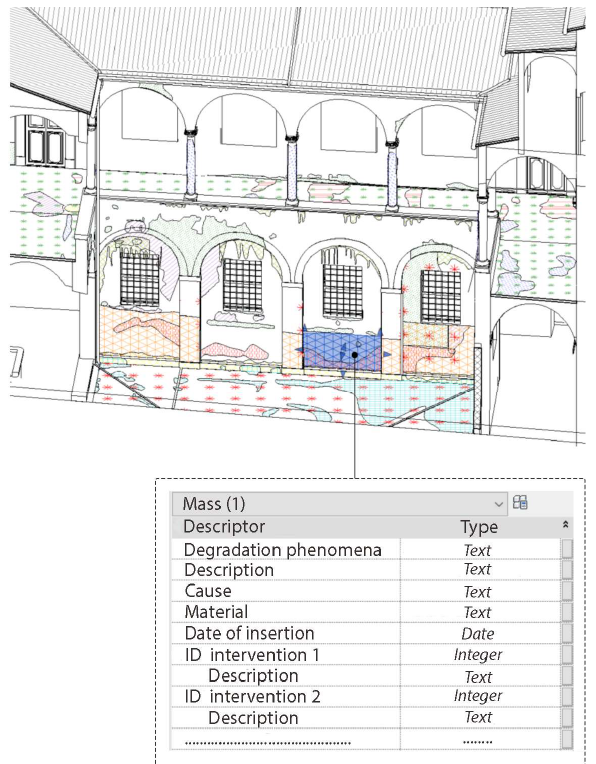
Figure 3. Tags and attributes type annotations within H-BIM